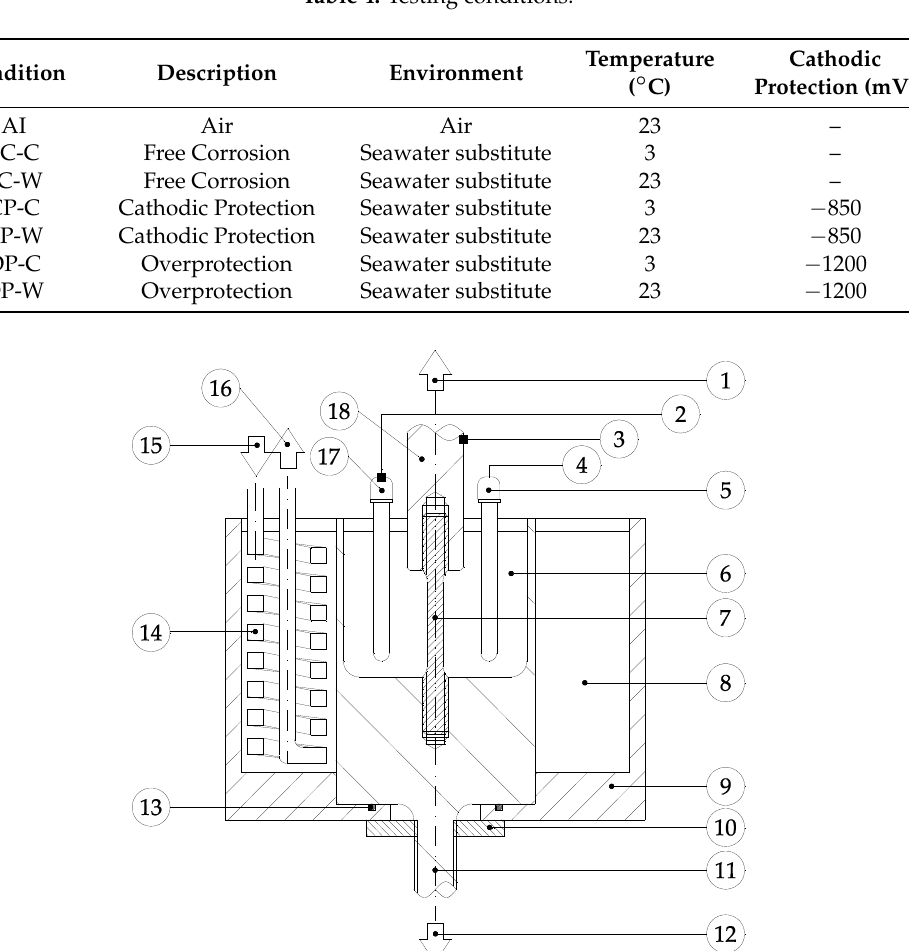
Table 4. Testing conditions.